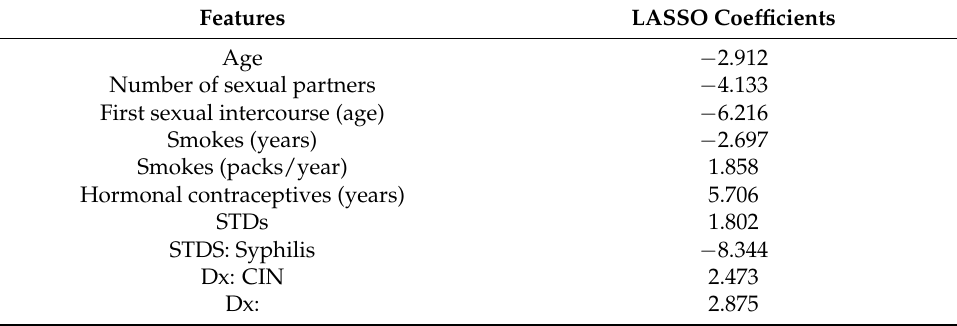
Table 4. Features selected by LASSO with their estimated coefficients.